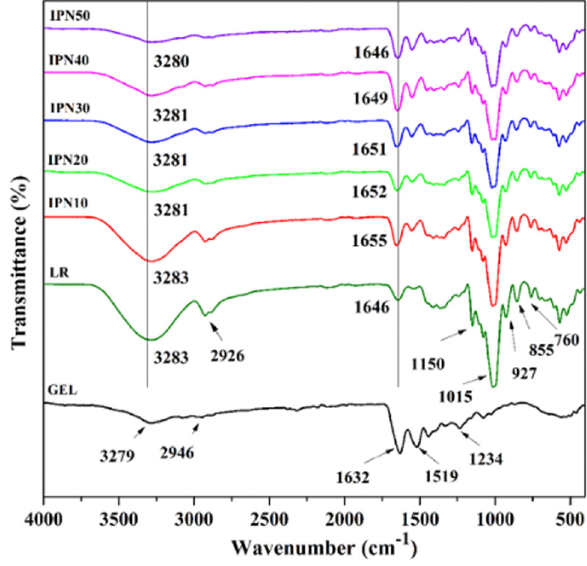
Figure 1: FTIR spectroscopy of GEL powder, LR, and IPN fi